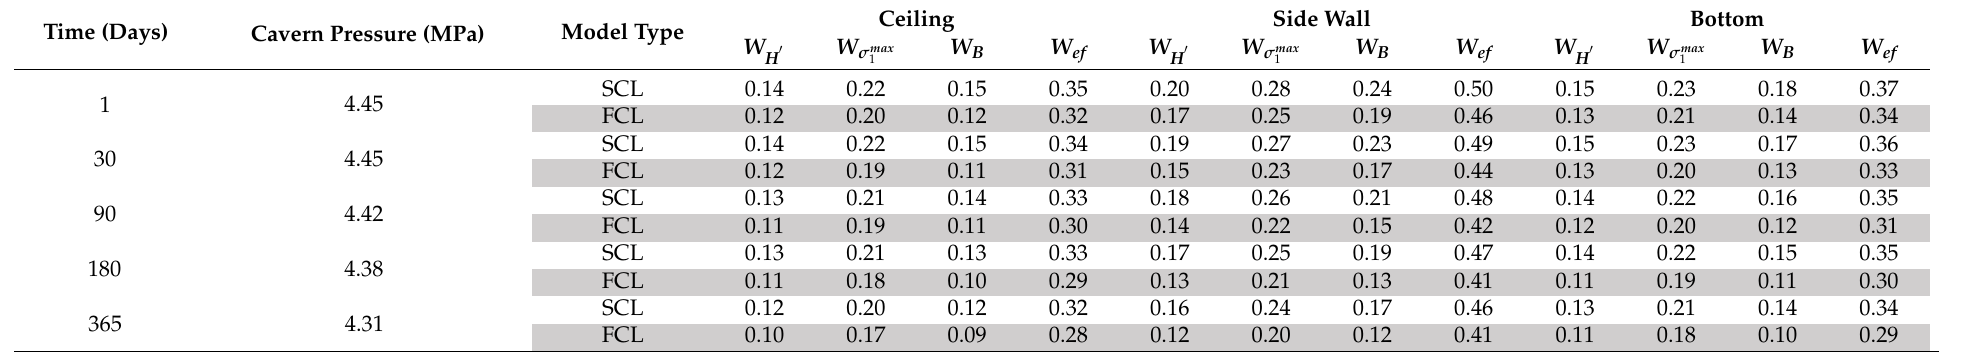
Table A1. Strength criteria for the two salt-creep models. Status at the end of the downloading cycle (after emptying the cavern to the minimum pressure). Time (Days)